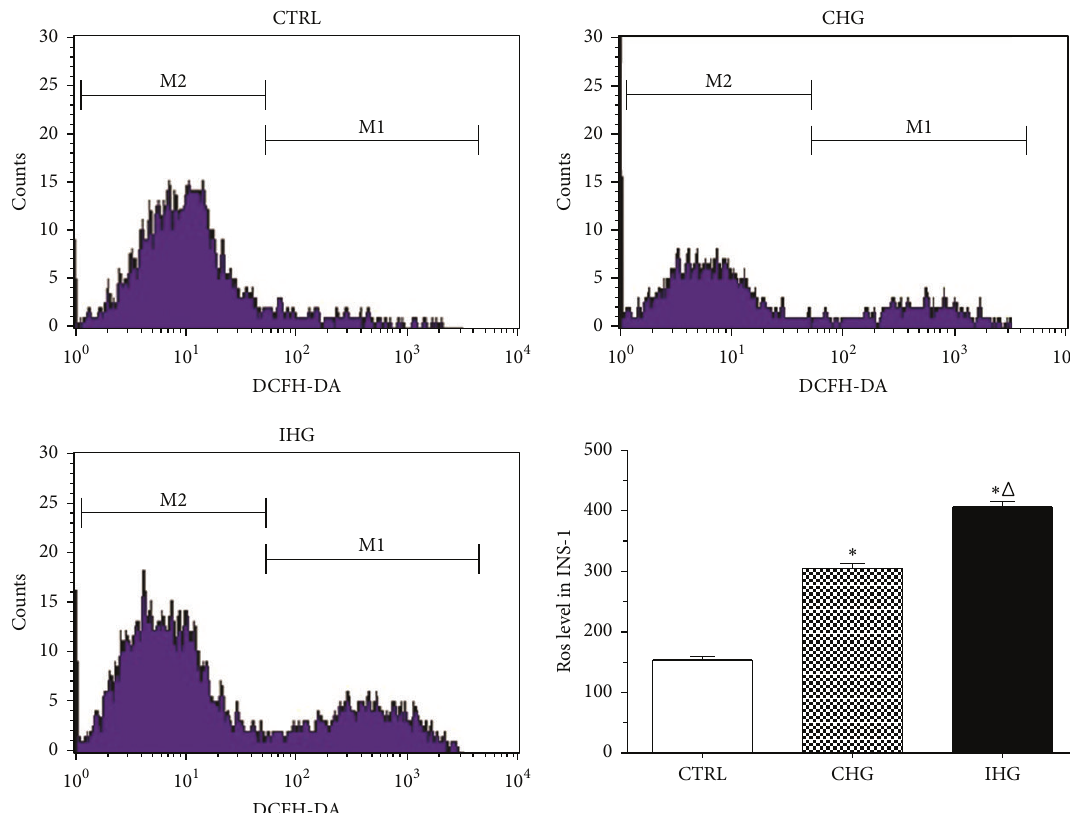
Figure 2: Intracellular reactive oxygen species level of INS-1 cells with DCFH-DA staining. Images of DCFH-DA staining and data of fluorescence intensity analysis for INS-1 cells exposed to different treatment by flow cytometry were demonstrated. Control, normal glucose; CHG, constant high glucose; IHG, intermittent high glucose. ∗ 𝑃 < 0.05 and Δ 𝑃 < 0.05 , respectively, indicate a significant difference from controls and